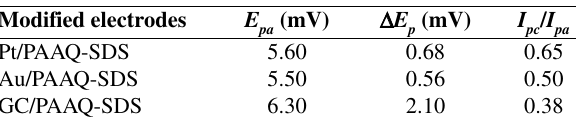
Table 1. Effect of substrates on response of modified electrodes in a phosphate buffer solution at pH 5.0 containing 2.0 mM of catec- hol.